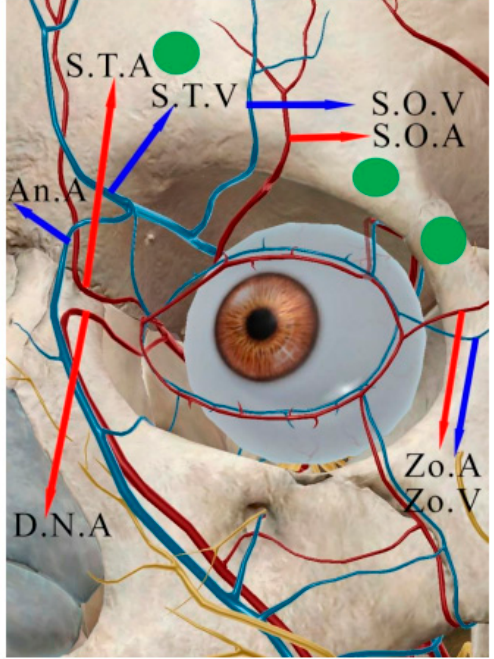
Figure 13. The typical branching pattern of the supraorbital artery and vein (S.O.A. and S.O.V.), the supratrochlear artery and vein (S.T.A. and S.T.V.), the dorsal nasal artery (D.N.A.), the angular vein (An.V.), and the zygomaticoorbital artery and vein (Zo.A. and Zo.V.), as well as the cannula entrance positions (green circles).